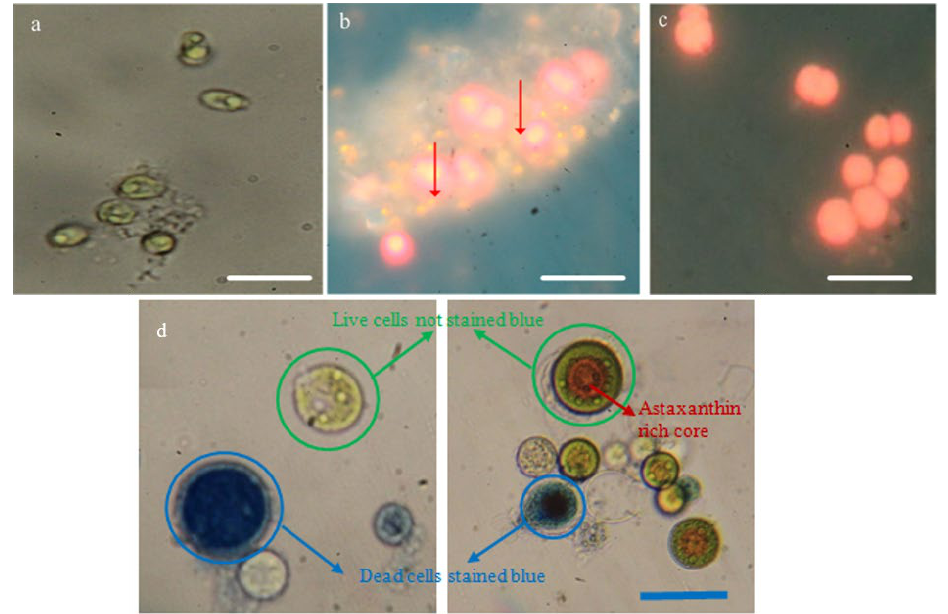
Figure 5. ( a ) Intact Chlorella vulgaris cells before staining under an optical microscope. ( b ) Histochemical localization of lipid bodies in the cells after staining with Nile red under a fluorescent microscope. ( c ) The unstained algae under a fluorescent microscope with the characteristic red fluorescence. Red arrows indicate the stained lipid globules emitting fluorescence at 575 nm. Reprinted with permission from [76]. ( d ) Light microscopy images of live versus dead microalgae Haematococcus pluvialis. Scale bar corresponds to 20 µm. Table 2. Histological observation of living cells under different environmental